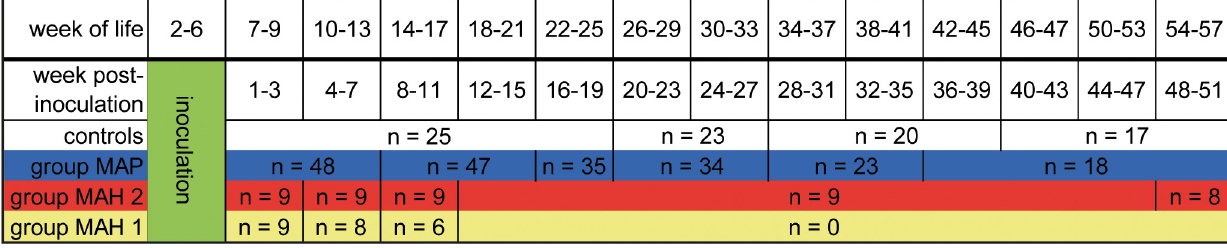
Fig 1. Study design. MAP, group infected with Mycobacterium avium subsp. paratuberculosis . MAH, group infected with Mycobacterium avium subsp. hominissuis